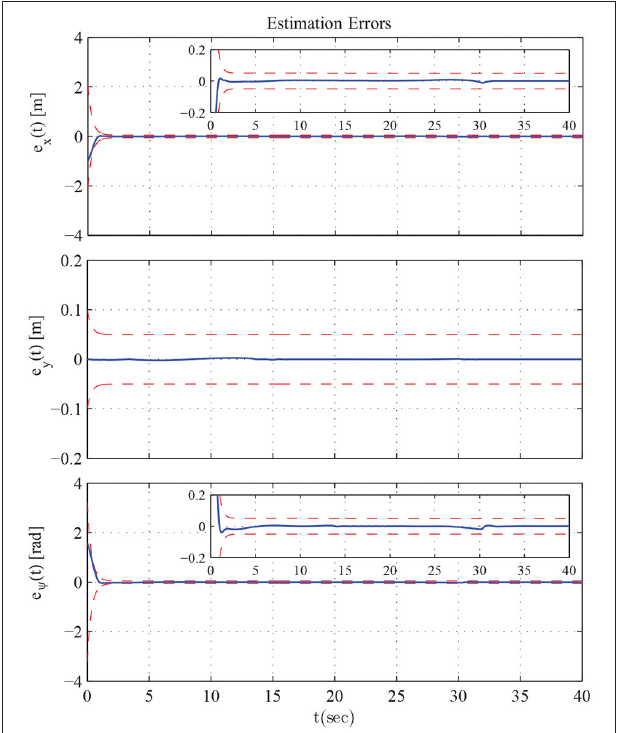
FIGURE 12 | The estimation errors along with the performance bounds imposed by the proposed method.